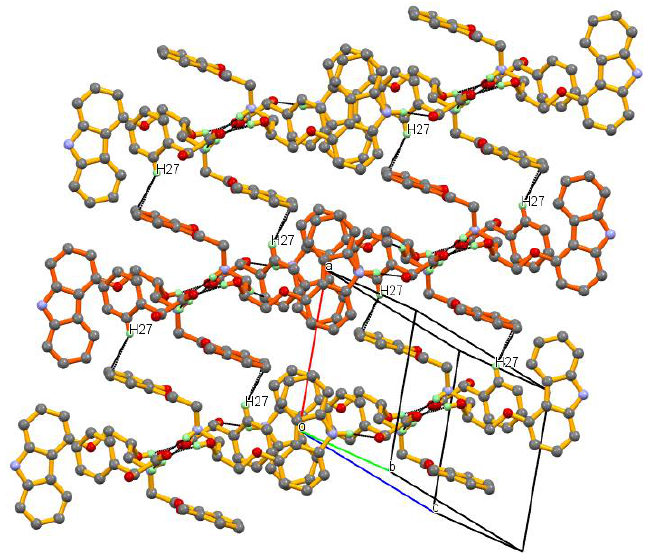
··· π (C27–H27 ··· Cg4) interaction along a